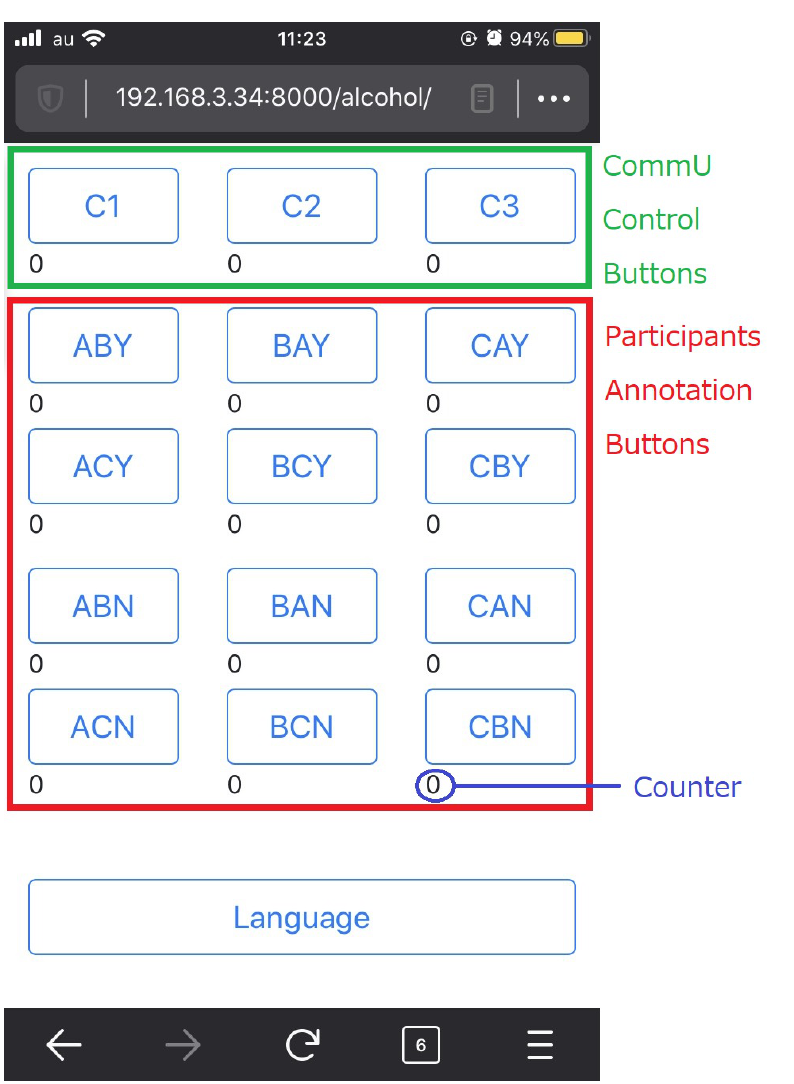
Figure 4. User interface of the website to activate robots and make annotations on participants’ routes on the smartphone. As annotated in the image, the buttons C1, C2, and C3 activate the robots, while other buttons were used to record the participants’ routes and whether they used the hand sanitizer. Below each button is a counter to show how many times each button was